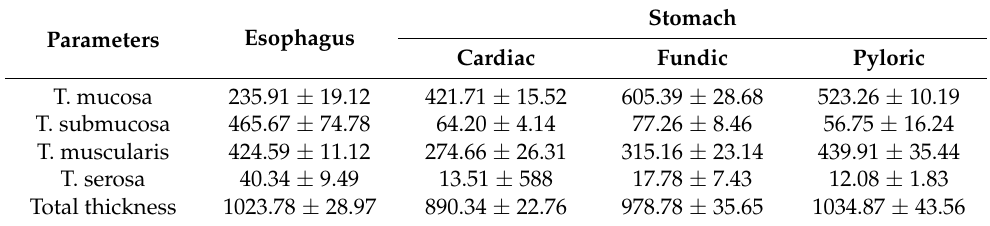
Table 2. The histometric measurements ( µ m) of esophagus and stomach of adult male D. leporina ( n =